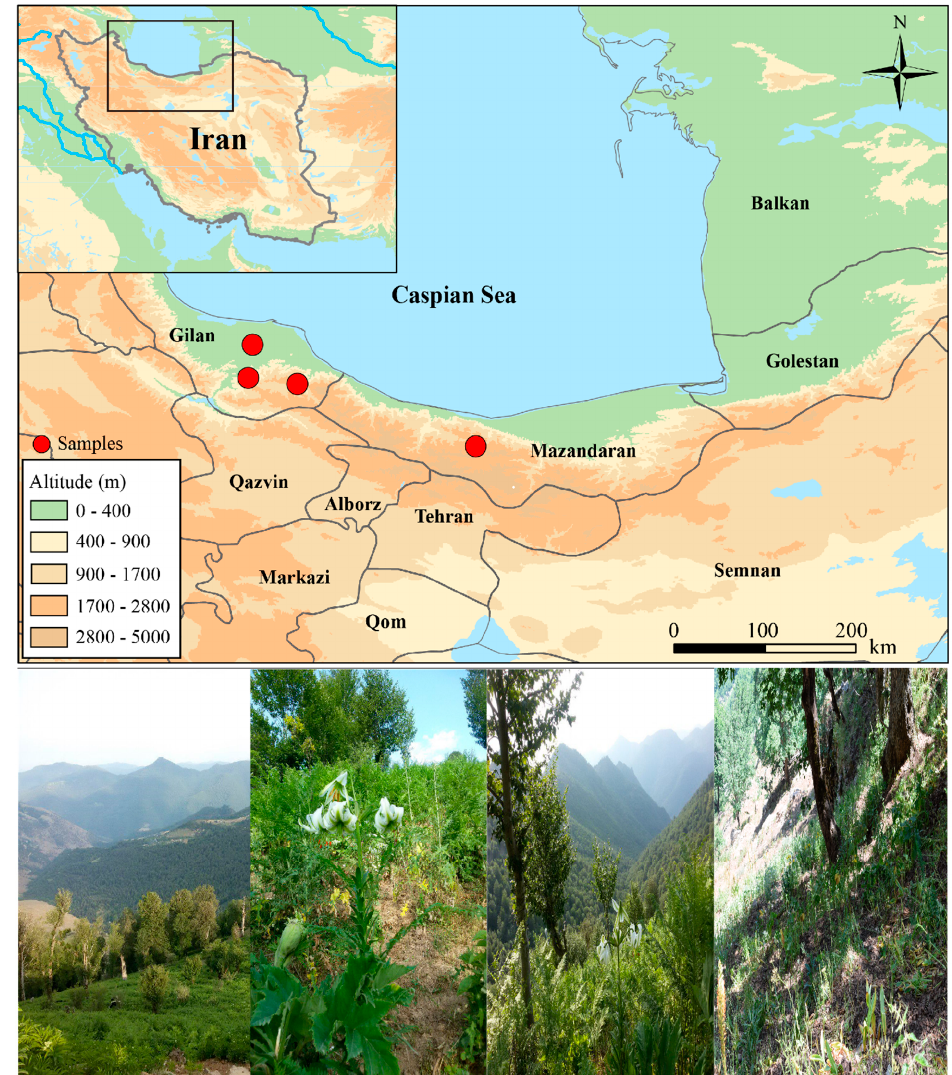
Figure 1. Geographical s ampling sites of Lilium ledebourii in the Hyrcanian forest, part of Iran.